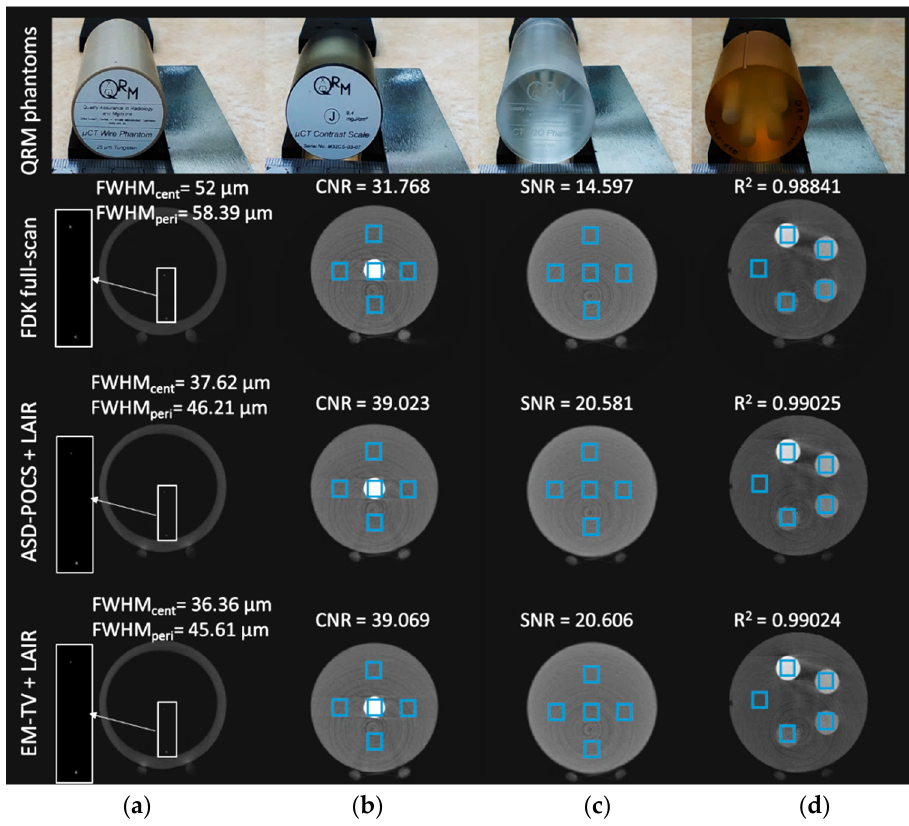
Figure 8. The reconstructed images from the FDK method in DSFC mode and the proposed stopping criteria included in the two LAIR algorithms (ASD-POCS and EM-TV) for four standard physical phantoms including ( a ) 25- µ m wire phantom; ( b ) contrast-scale phantom; ( c ) water phantom and ( d ) HA phantom. The display’s dynamic range was set to the maximum for each different phantom image and the same scale between different algorithms automatically. For details of image analysis, please refer to Figure 4. The standard deviation of the fitted Gaussian function was calculated as 21.739 µ m under the geometry of SID of 211.1 mm and SOD of 49 mm conditions to measure the radial spatial resolutions. The 3 × 3 mm 2 ROIs were applied to the CNR, SNR and linearity measurements.